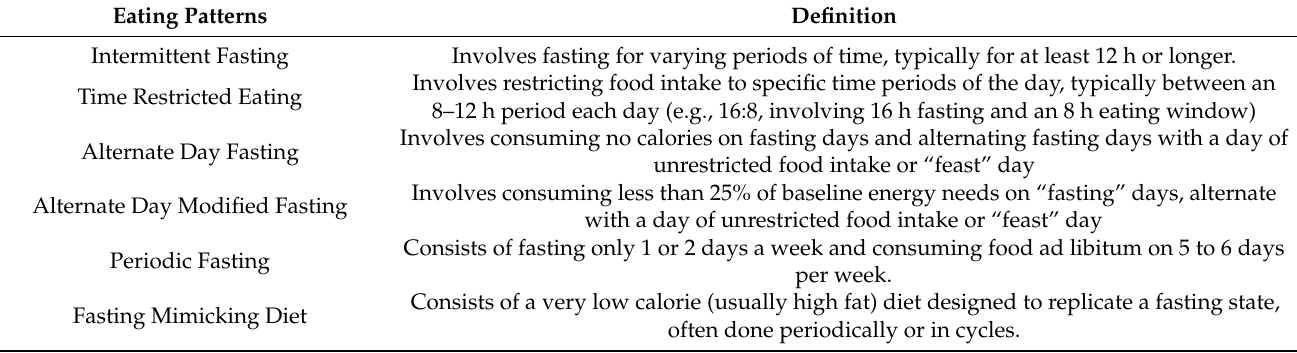
Table 1. Definition of terms used to describe different types of fasting or calorie restricted eating patterns (adapted from [76]). Eating